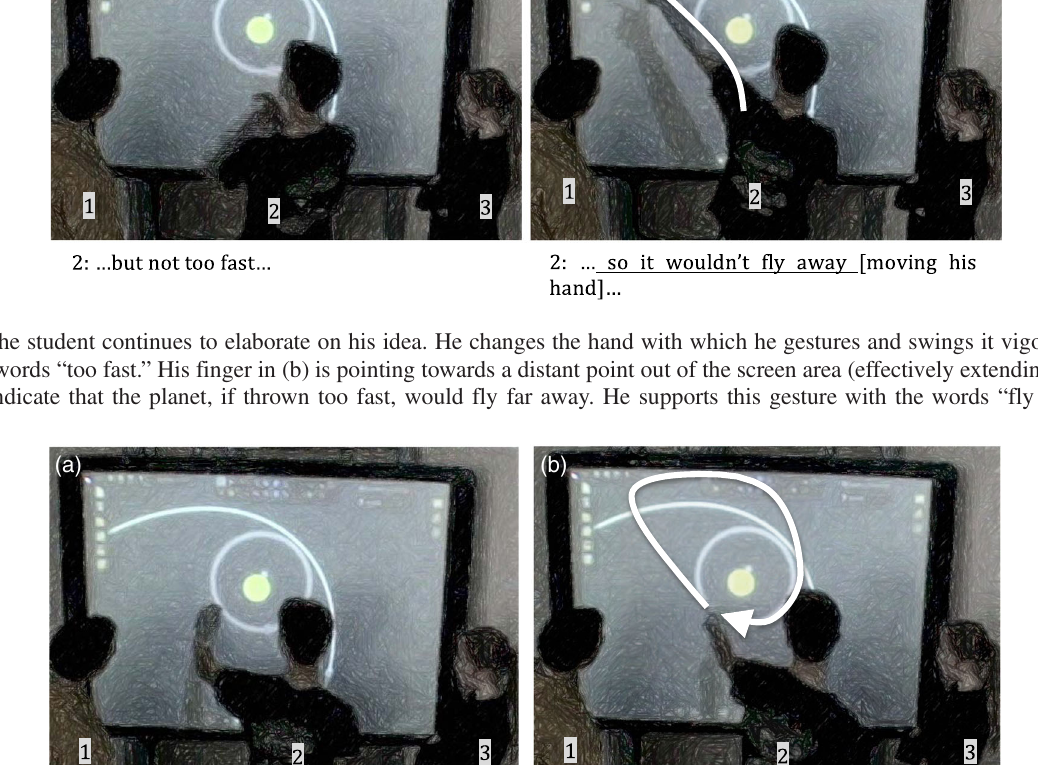
FIG. 7. Finally, student 2 gives a prediction of what he expects to happen in the “ faster throw ” experiment. He traces out the predicted path of the planet, starting and finishing it at the same point on the screen. The shape that he draws is quite irregular, not very similar to an ellipse, but this can be due to the lack of available screen area, the limited extent of the student ’ s reach, and the student drawing the shape in a quick and rough style. Once again, the gesture can be seen as referring to both the planet motion and the geometrical shape of the